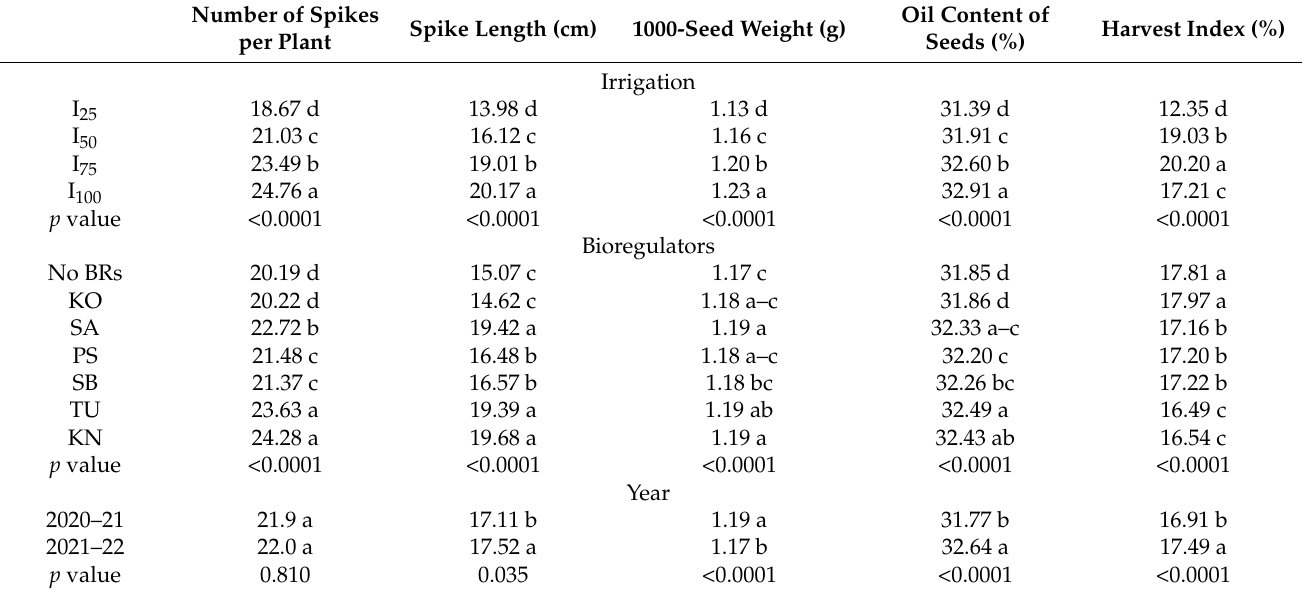
Table 3. Changes in yield attributes of chia under deficit irrigation regimes and bioregulators